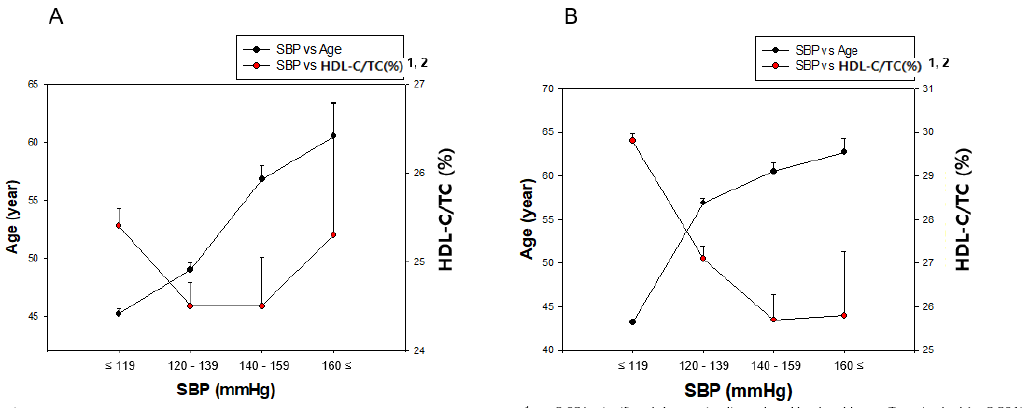
Figure 6. Correlation of age and HDL-C / TC (%) depends on SBP in men ( A ) and women ( B ). Negative association was found between age and HDL-C / TC (%) depends on SBP in women ( B ) by J–T test. Pearson’s correlation analysis was carried out between age, HDL-C / TC (%), and SBP in men ( A ) and women ( B ). Men ( A ) showed r = − 0.065 ( p = 0.003) and women (B) showed r = − 0.208 ( p < 0.001) between SBP and HDL-C / TC (%).